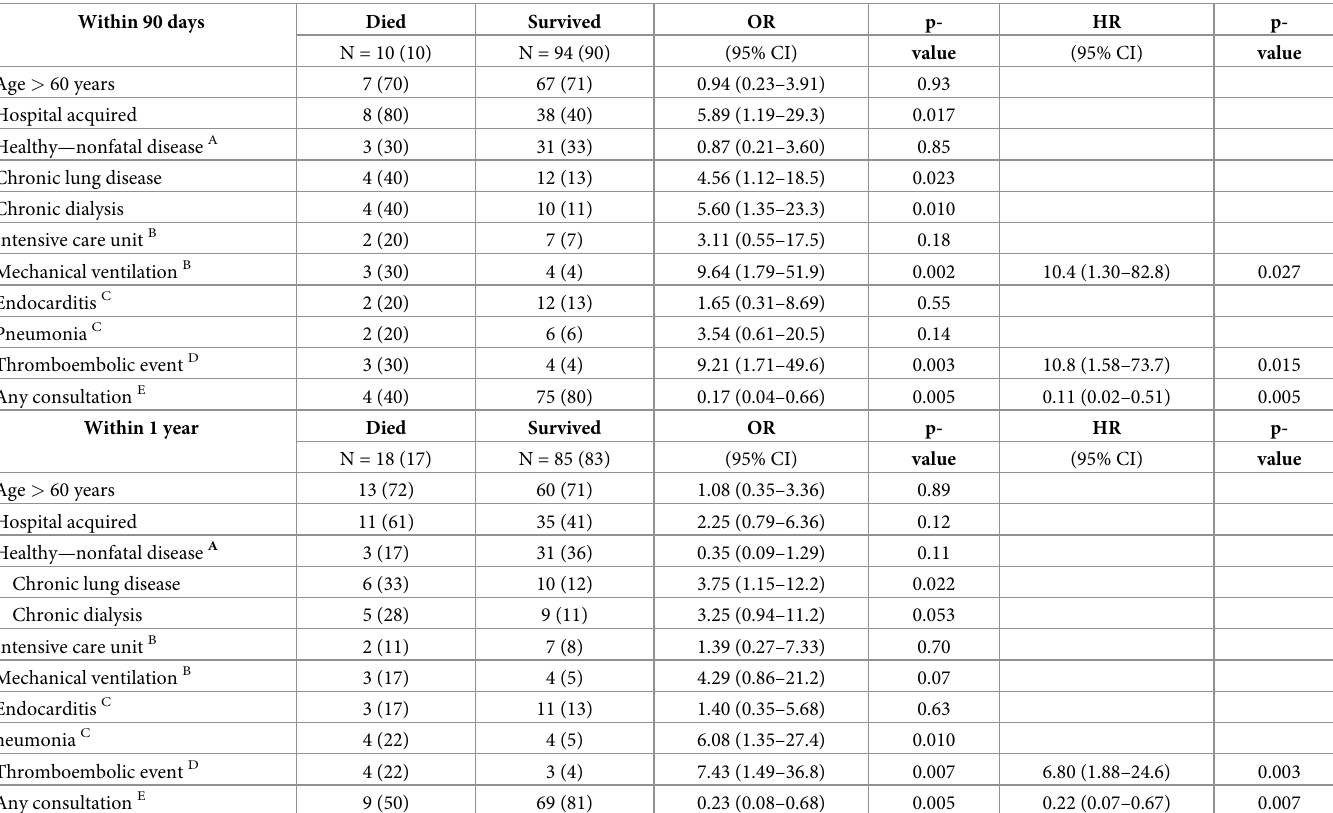
Table 4. Cox proportional hazards regression model for prognostic factors for 90 days and 1 year mortality of 104 patients with Staphylococcus lugdunensis bacter- emia (SLB) patients. Within 90